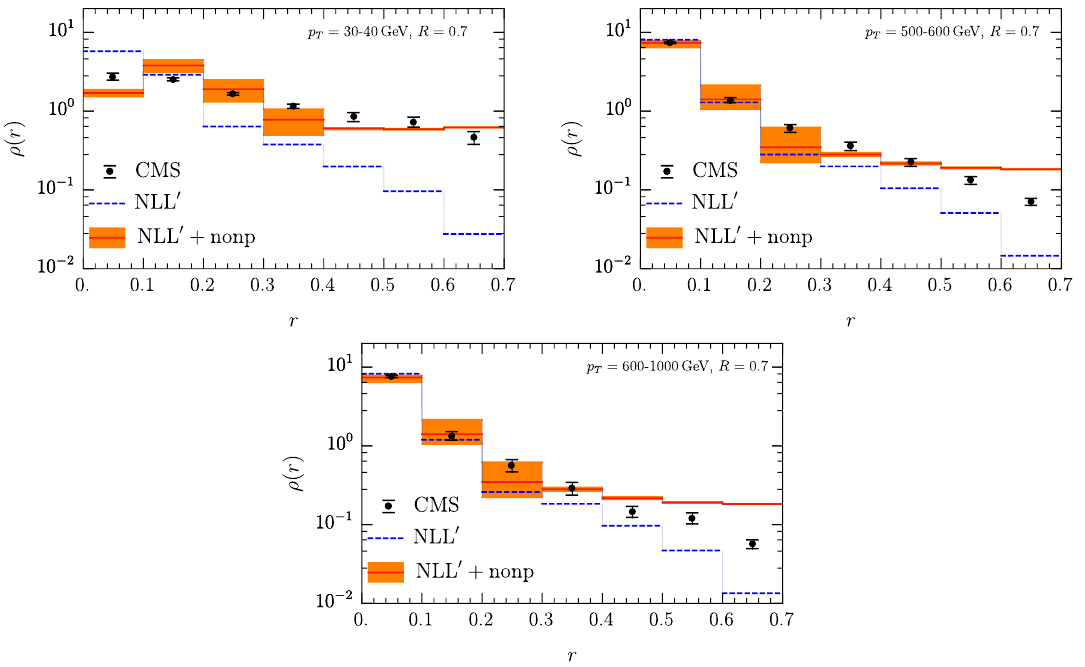
Figure 13 . Comparison of our numerical results for the di(cid:11)erential jet shape (cid:26) ( r ) to the CMS data of ref. [20]. The jets are obtained using anti-k T with R = 0 : 7 and, show the result for three intervals of the jet transverse momentum in the range of p T = 30{1000 GeV, as labeled in the di(cid:11)erent